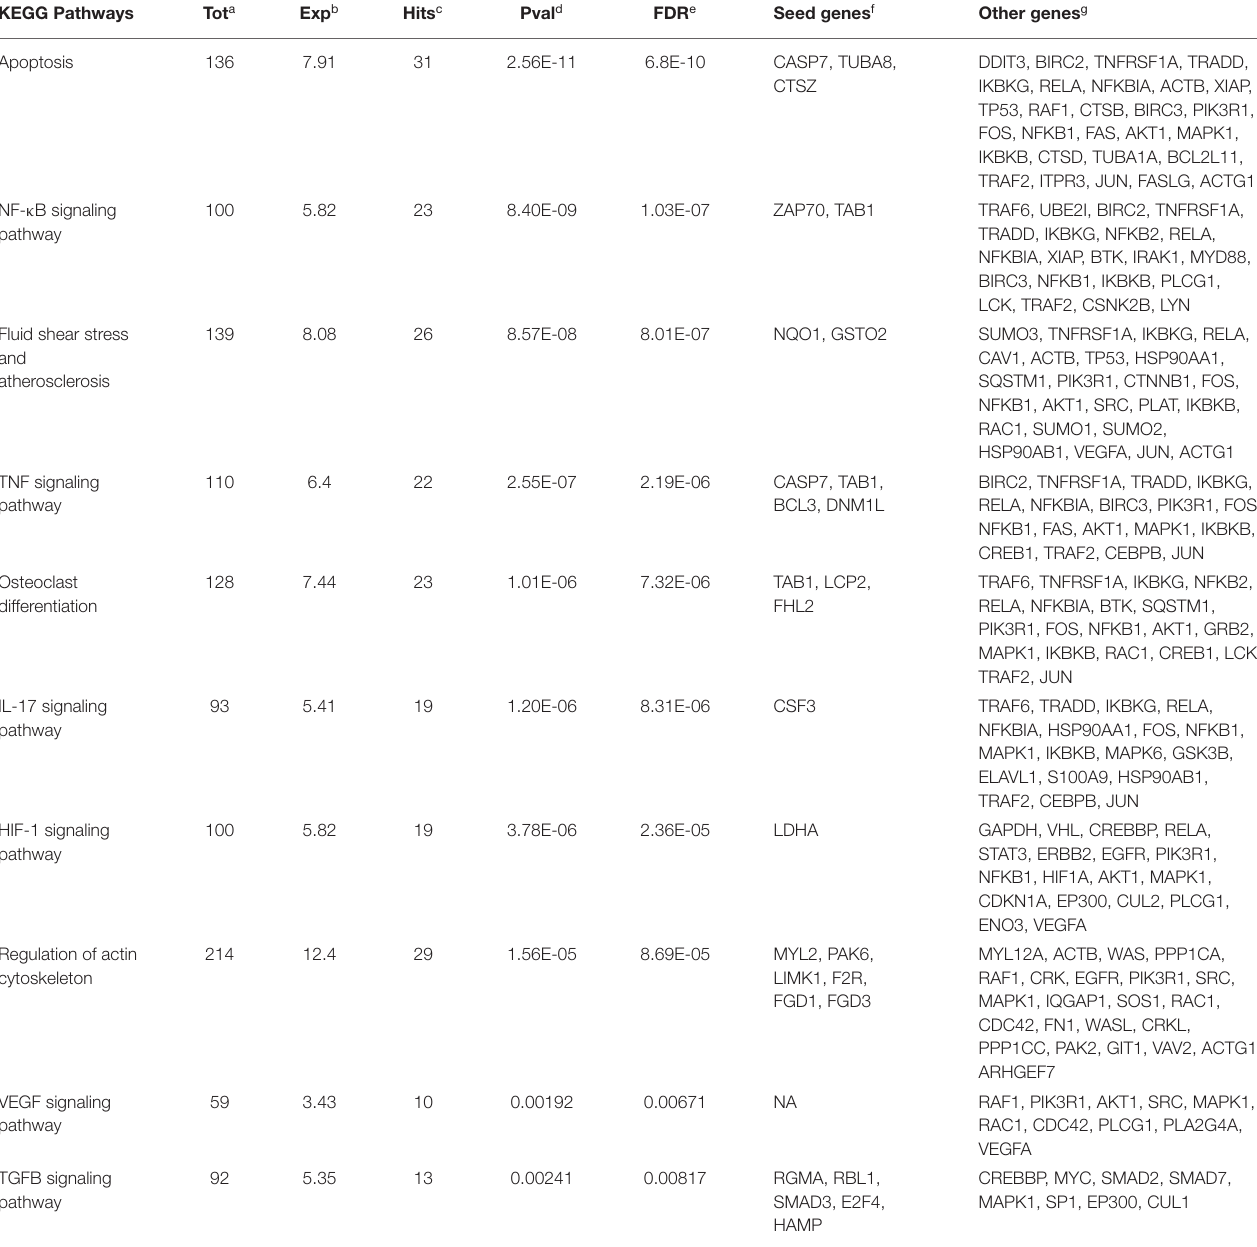
TABLE 2 | List of pathways resulting from enrichment analysis of the network ( Figure 4A ) constructed upon the genes associated with the differentially methylated hypo- and hypermethylated promoters using the KEGG pathway database. KEGG